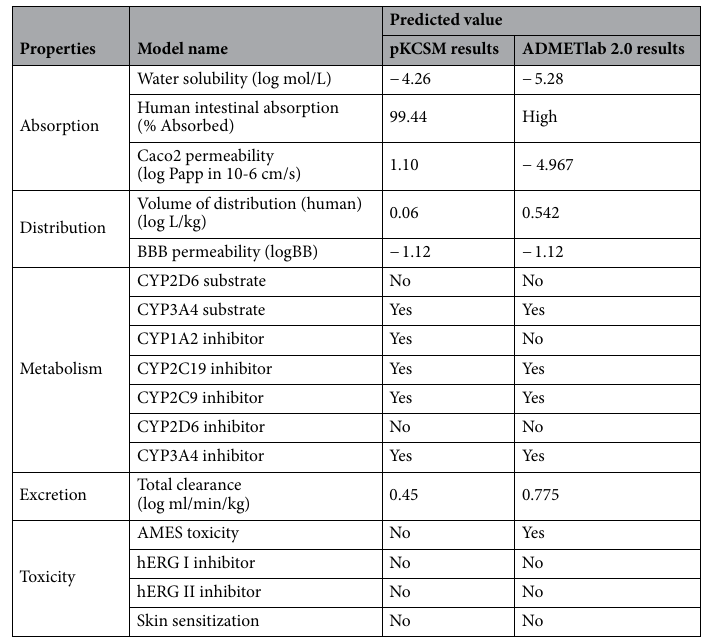
Table 7. Predicted ADMET (Absorption, distribution, metabolism, excretion, and toxicity) properties of 15K.